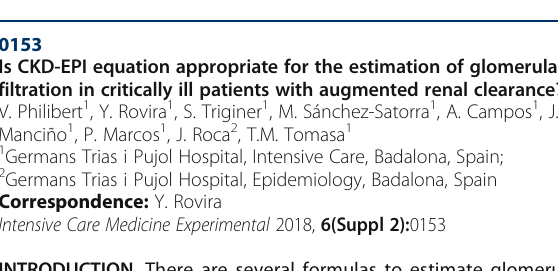
Fig. 1 (abstract 0153). mGFR and eGFR correlation (r= 0.20) in patients with